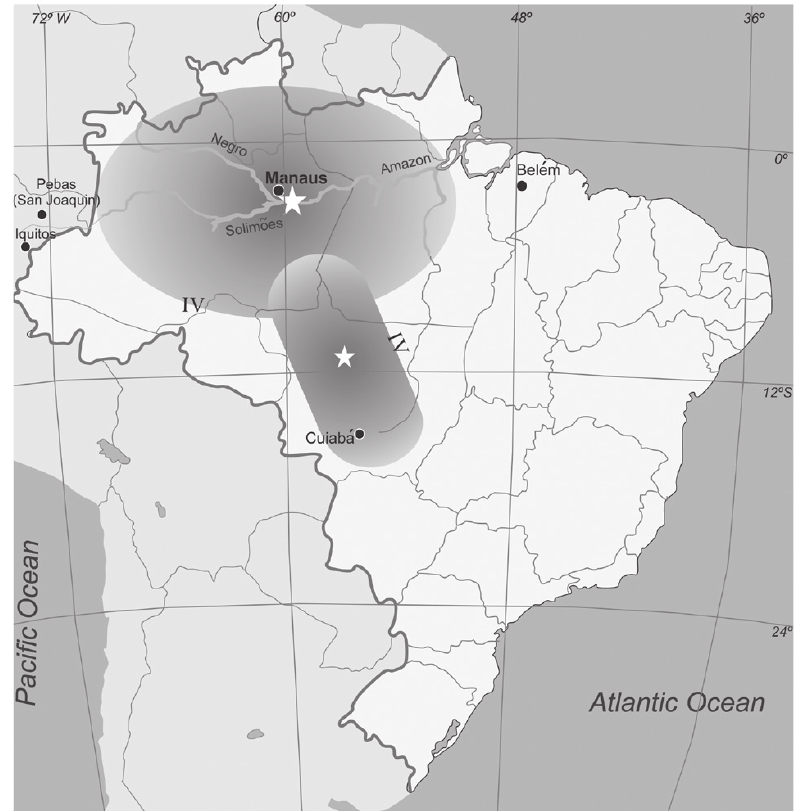
Fig. 4 - Comparison between estimated felt areas of the 1690 earthquake and the January 31, 1955 tremor, the largest ever recorded in Brazil (6.2 mb). Two shaded shapes represent the best fit ellipses for intensities IVMM centered at estimated epicenters. Data do not exist to indicate intensities to the north of 1955 epicenter and as result that isoseismal line was inferred. The estimated felt area of the 1690 and 1955 earthquakes are about 2 million square kilometers and 600.000 square kilometers,